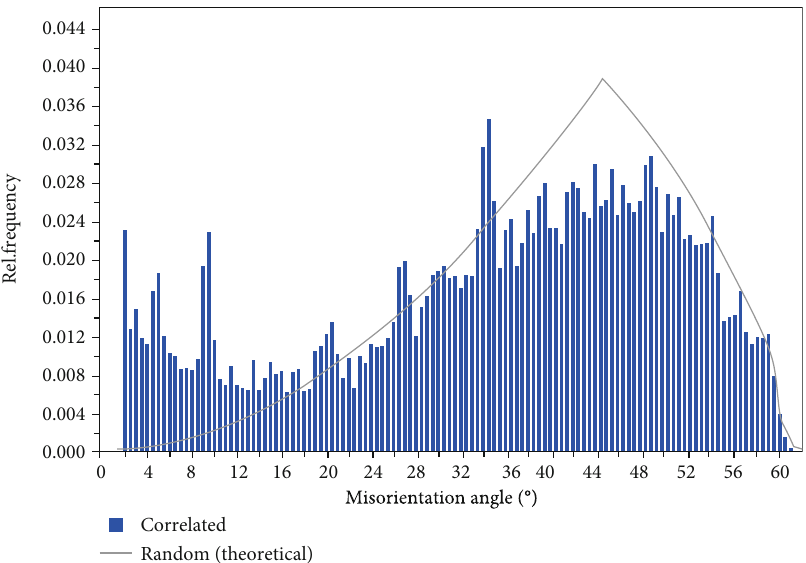
Figure 4: Misorientation angle of grains of the 3A21/7075 cladding